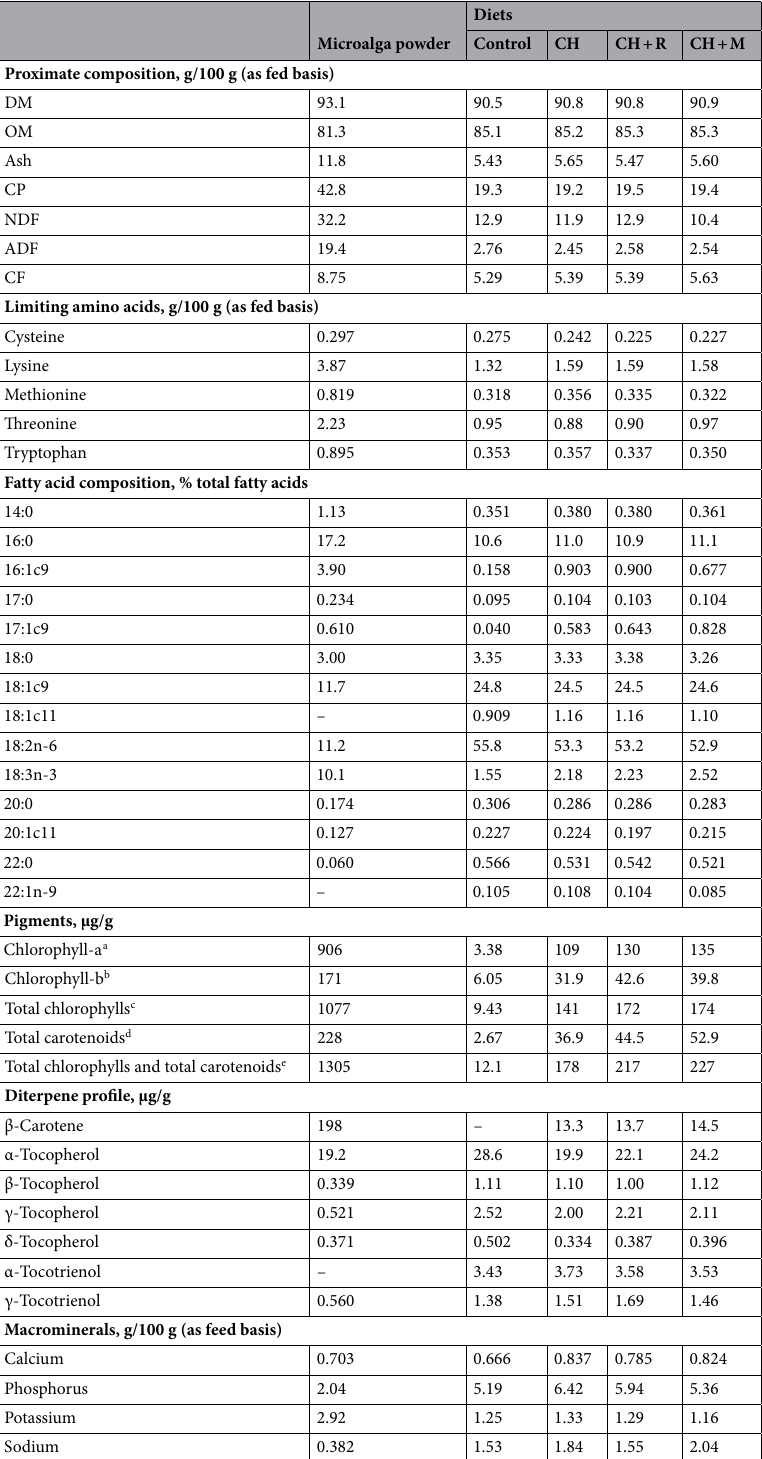
Table 6. Chemical composition of Chlorella vulgaris microalga and experimental diets. Control = control diet; CH = Chlorella vulgaris diet; CH + R = C. vulgaris diet supplemented with Rovabio® Excel AP; CH + M = C. vulgaris diet supplemented with a pre-selected enzymatic mixture. DM dry matter, OM organic matter, CP crude protein, NDF neutral detergent fibre, ADF acid detergent fibre, CF crude fat. a